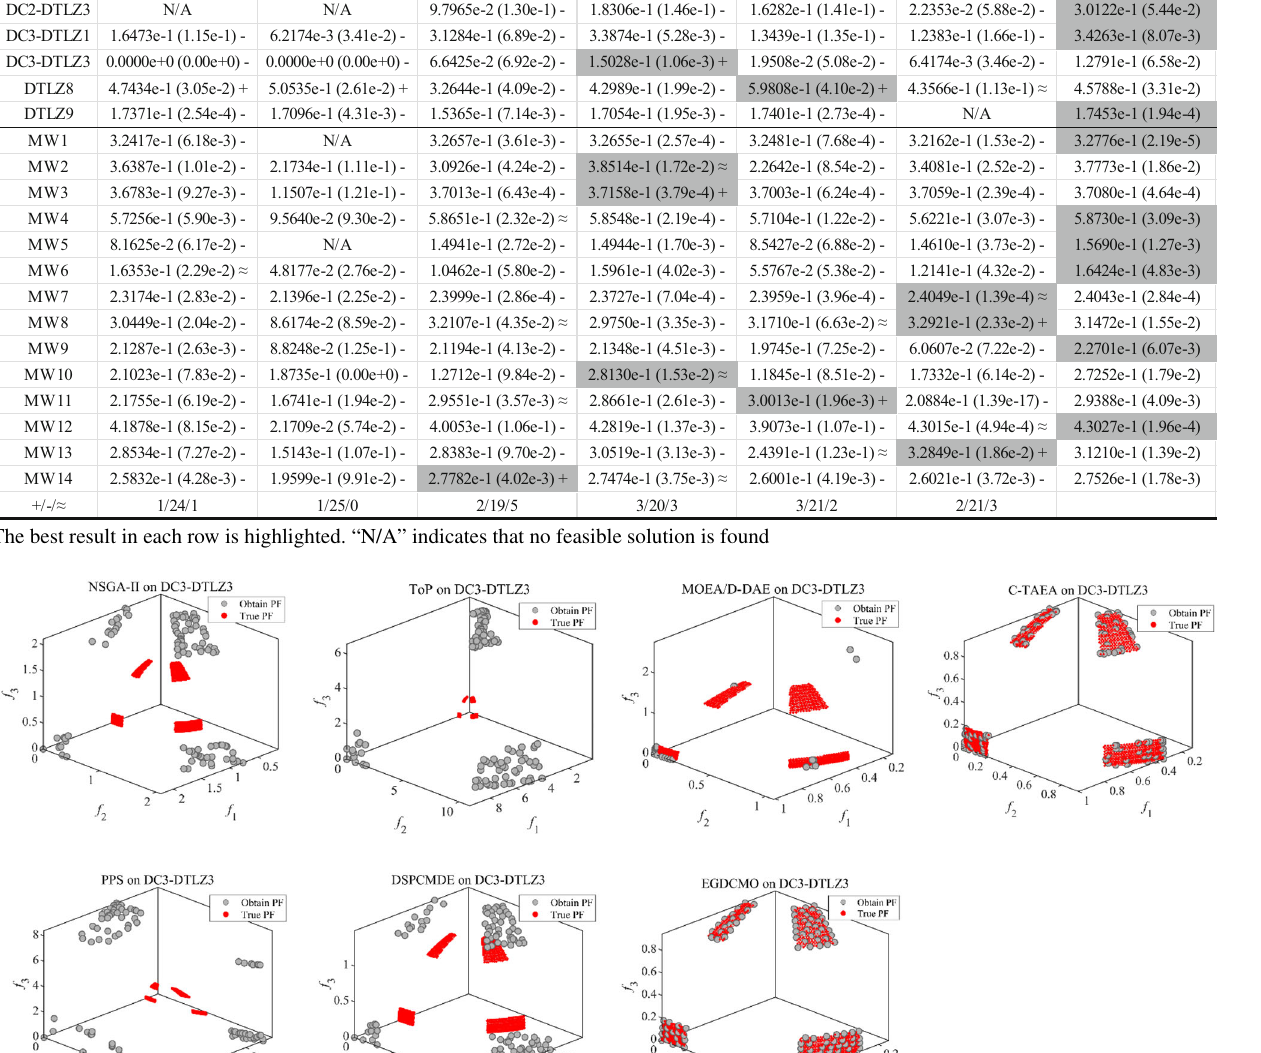
6, the numbers of best results obtained by NSGA-II, ToP, MOEA/D-DAE, C-TAEA, PPS, and DSPCMDE are 0, 0, 2, 5, 2, 3, and 14, respectively. Besides, it can be found that six compared CMOEAs are significantly worse than EGDCMO on 24, 25, 19, 20, 21, and 21 test problems, respectively.